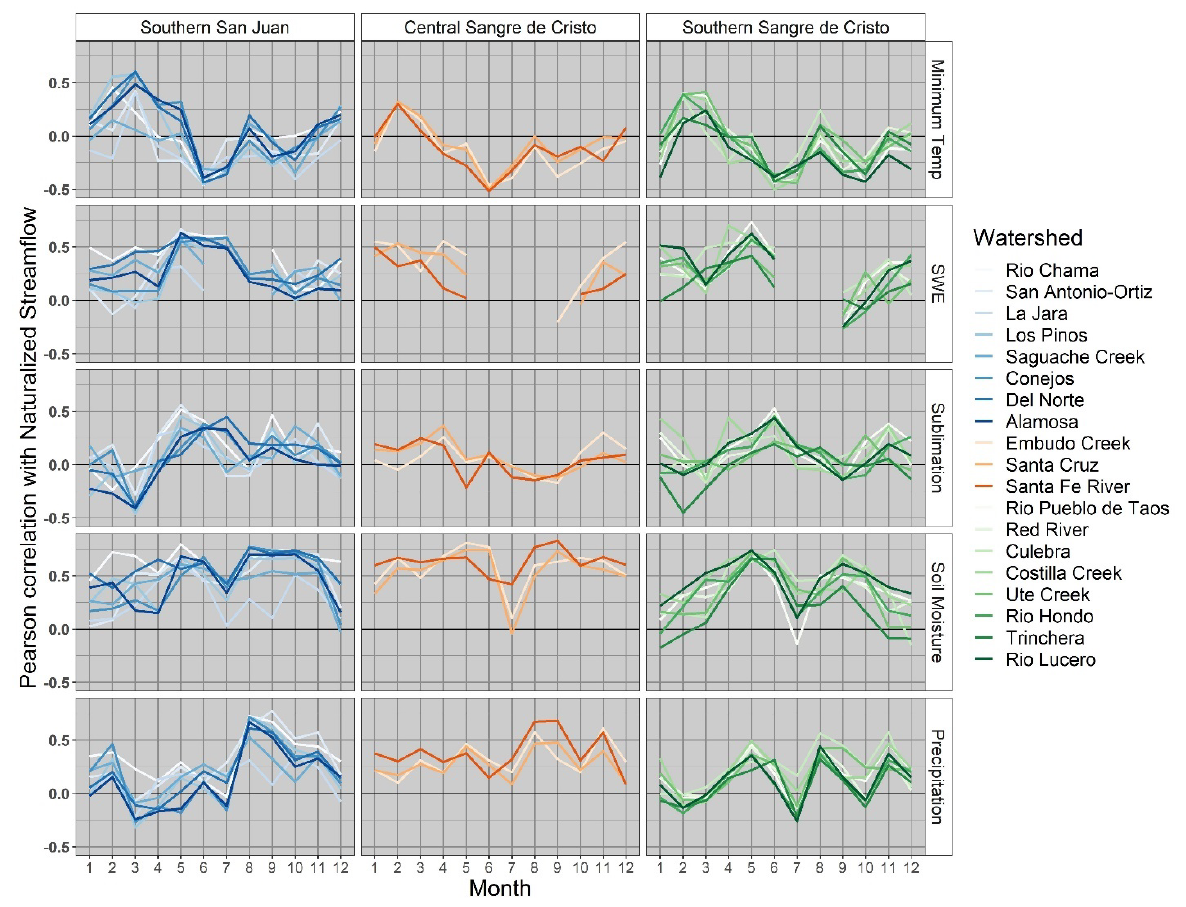
Figure 8. Line plots of monthly correlation of the variables with streamflow.